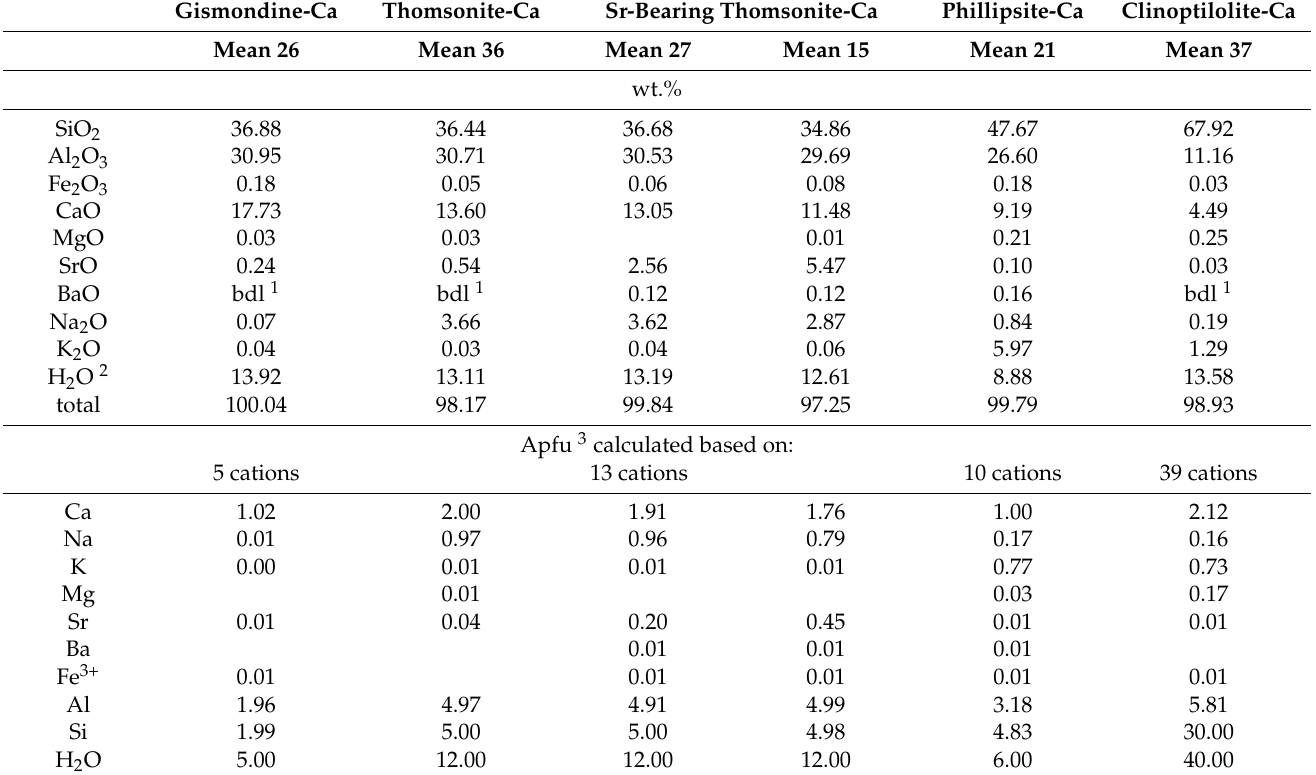
Table 4. Results of chemical analyses of zeolites from the zeolite-bearing rocks. Gismondine-Ca